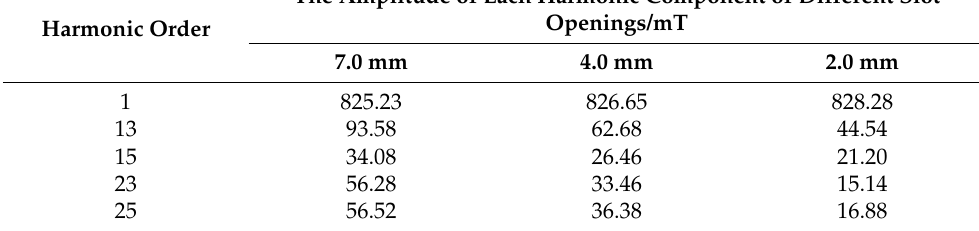
Table 3. FFT on air gap flux density.